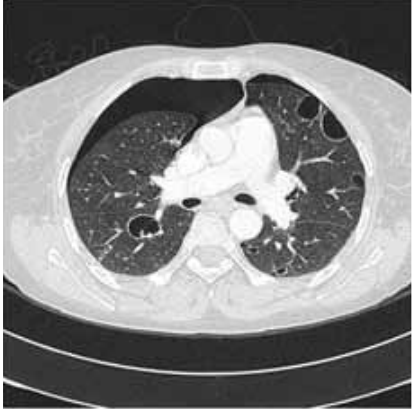
Fig. 3. Lung CT of a patient with metastatic epithelioid trophoblastic tumour (ETT). Note the irregular thin-walled cystic structures with ruptured subpleural lesions, resulting in bilateral